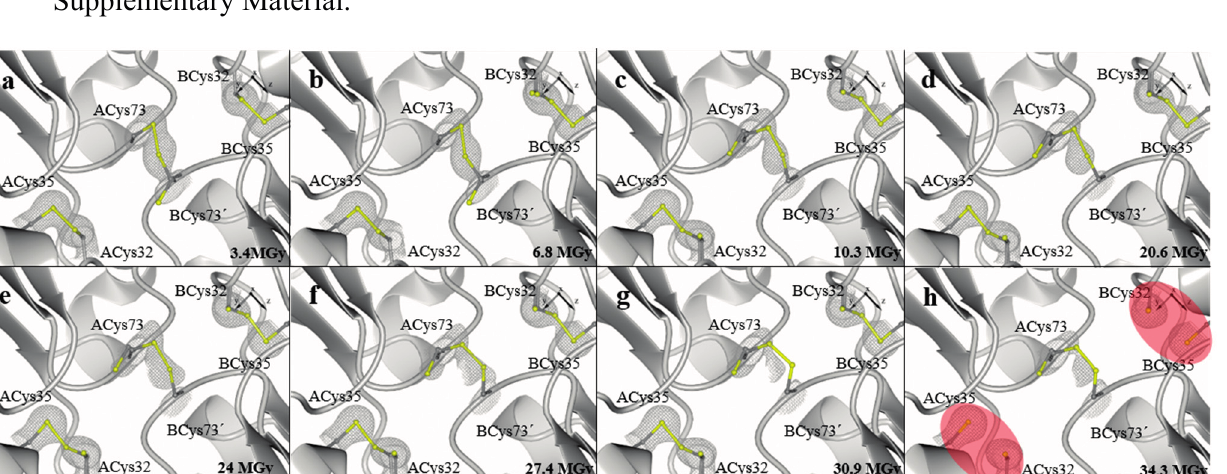
Figure 2. Crystal structures of Lv Trx-1x showing the disulfide bond deterioration (ACys32-ACys35, ACys73-BCys73' and BCys32-BCys35) caused by radiation damage in a sequential data collection of 10 datasets with 8% of transmission, 1.33 × 10 11 photons s − 1 . Electron-density maps 2Fo-Fc are shown in gray and contoured at 1.0 σ . ( a ) First dataset collected at 3.4 MGy; ( b ) second dataset collected at 6.8 MGy; ( c ) third dataset collected at 10.3 MGy; ( d ) sixth dataset collected at 20.6 MGy; ( e ) seventh dataset collected at 24 MGy; ( f ) eighth dataset collected at 27.4 MGy; ( g ) ninth dataset collected at 30.9 MGy; ( h ) tenth dataset collected at 34.3 MGy, showing that up to this dose, the catalytic disulfide bond of chains A and B is fully reduced (highlighted in red ovals), while the interface disulfide bond remains stable. For practical purposes, the fourth and fifth datasets are not shown at a dose of 13.7 MGy and 17.1 MGy, respectively, since these datasets did not provide more information. The figures were generated with CCP4mg, and the video can be viewed in the Supplementary